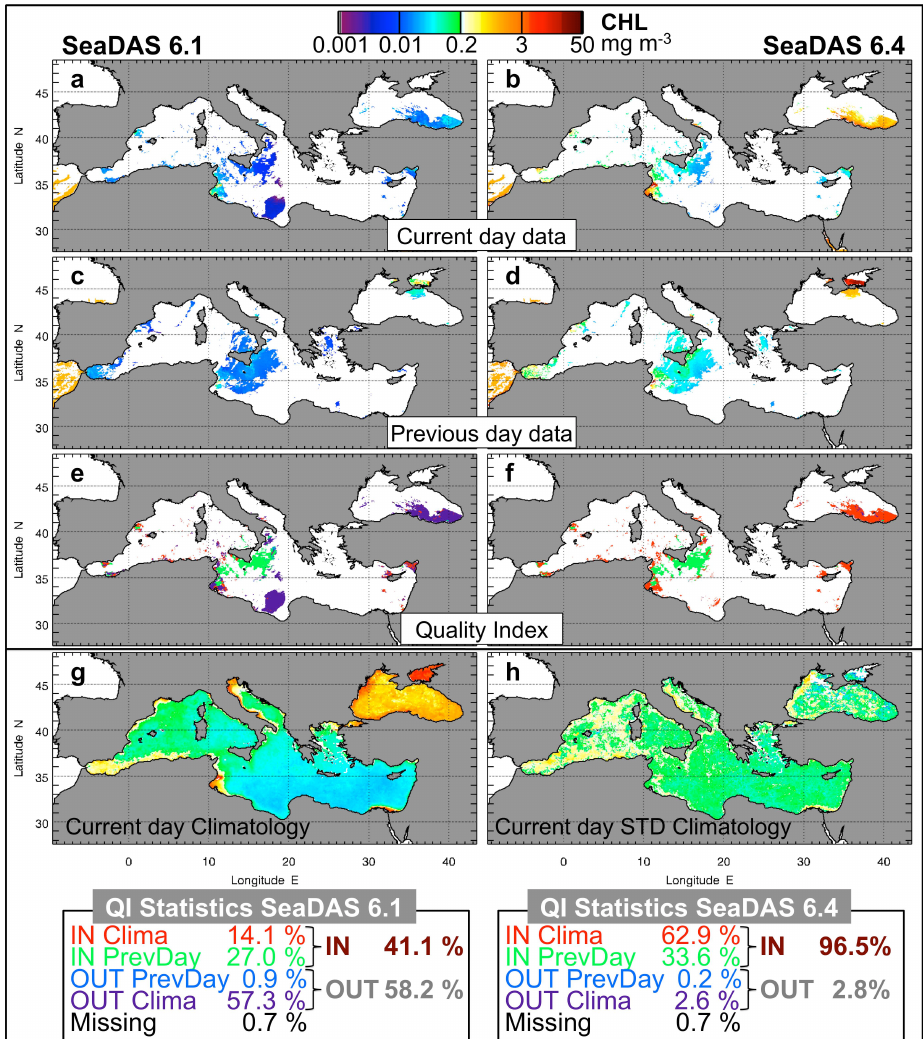
Fig. 6. Example of the online validation analysis over MODIS CHL image of the 13th December 2011. Panels (a–c–e) refer to the analysis performed using the current version of SeaDAS software (6.1), and are the daily MODIS DT CHL image, the previous day image, and the quality index, respectively. Panels (d–b–f) refer to the analysis performed using the latest version of SeaDAS software (6.4), and are the daily MODIS DT CHL image, the previous day image, and the quality index, respectively. Panels (g–h) represent the current day climatology and the current day STD climatology, respectively. Apart from panels (e–f) , whose colour legend is shown as QI statistics, all units are in mg m − 3 and refer to the colour bar. Numbers in the QI statistics are normalized to the total number of good pixels within the current day image, which are 15227 and 12315, respectively for SeaDAS 6.1 and SeaDAS